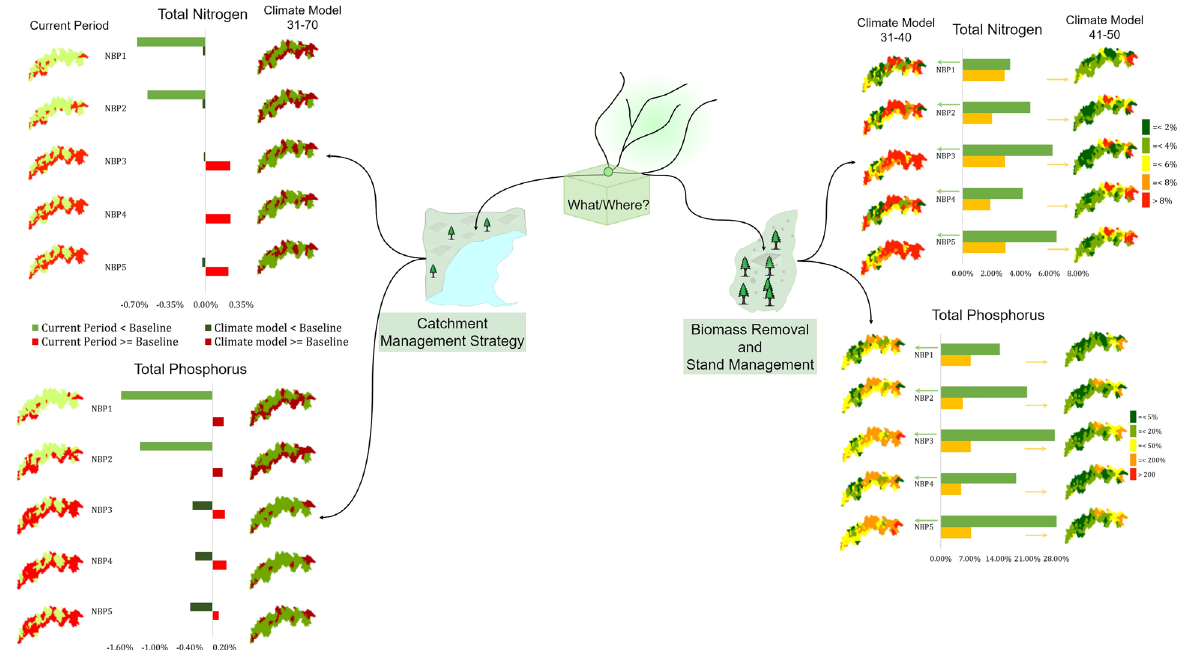
Figure 5. A recommended chart to follow for taking a managerial